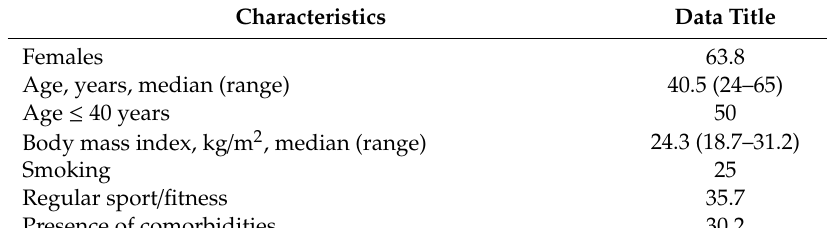
Table 2. Characteristics of SARS-CoV-2-positive health care